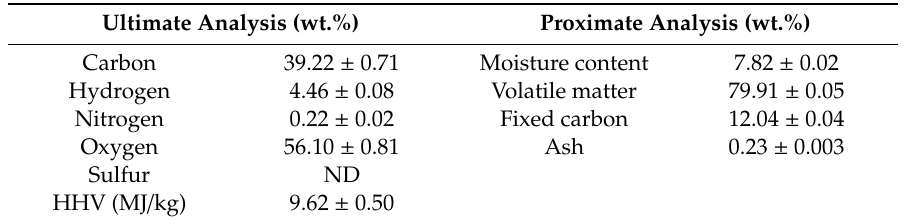
Table 1. Proximate and ultimate analysis of waste coconut shell.